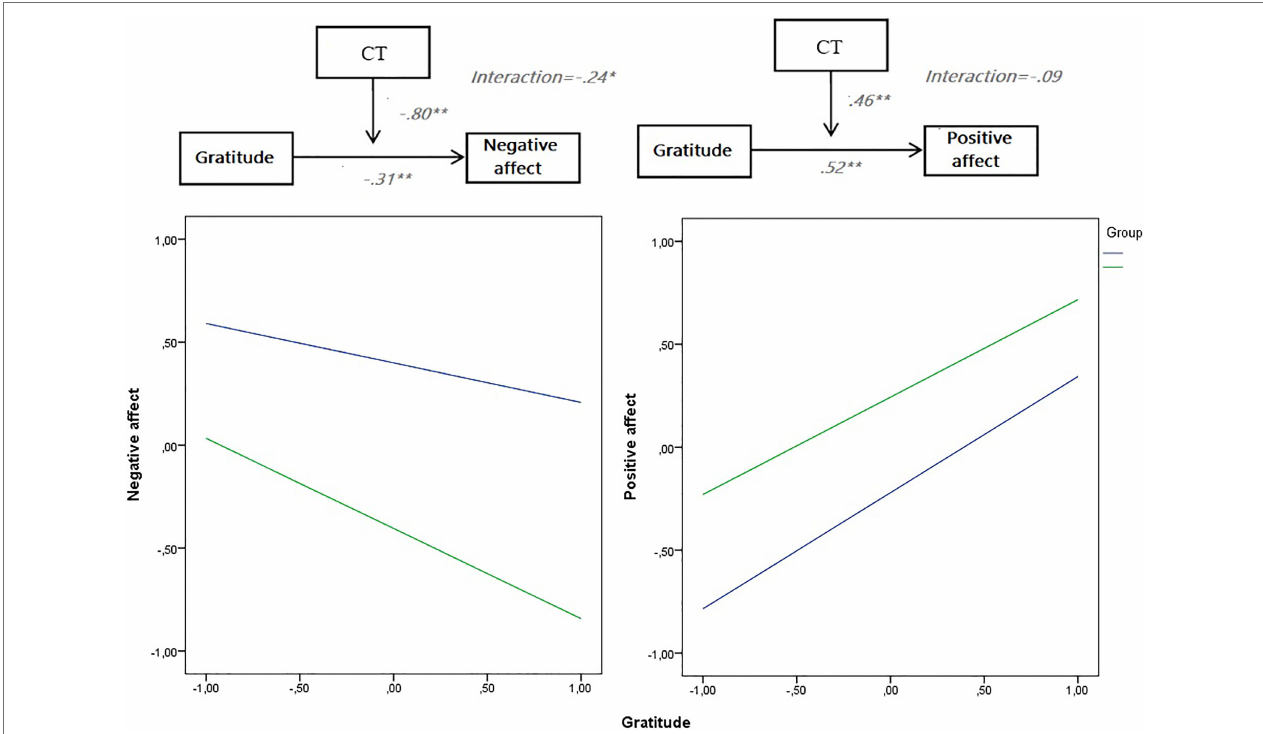
FIGURE 1 | Moderation model for gratitude and positive and negative affect across CT.